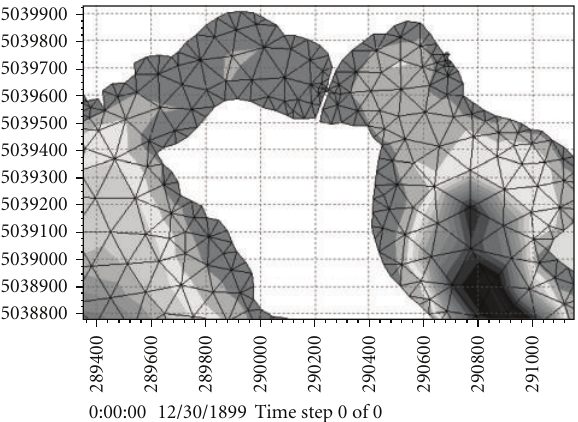
Figure 15: The mesh in the causeway area used for investigation of the hydraulic conditions under a causeway with a single opening.